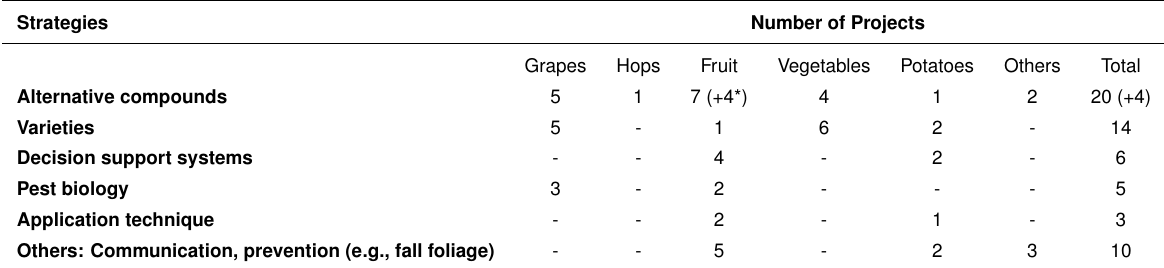
Table 11. Strategies for reducing copper application assessed within German research projects since 2001.